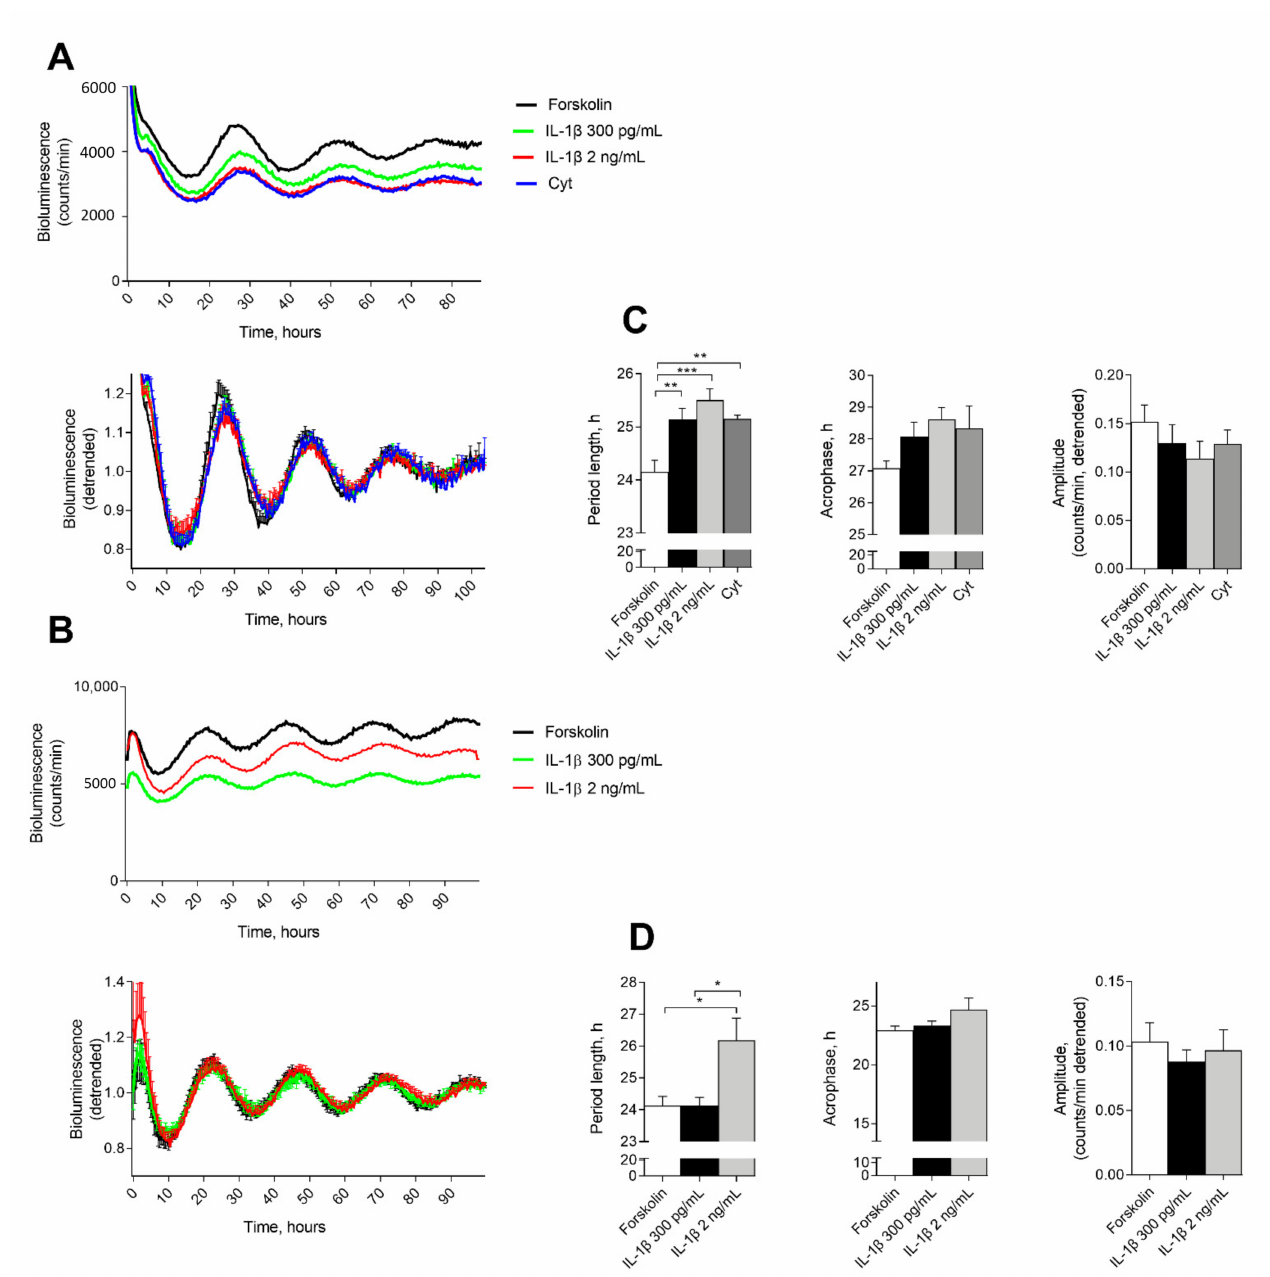
Figure 1. Proinflammatory cytokines alter the molecular clockwork in synchronized mouse and human Per2-luciferase (Per2-luc) reporter islets. ( A , B ) Average raw (top panels) and detrended (bottom panels) Per2-luc oscillatory profiles recorded from forskolin-synchronized mouse ( A , n = 5 of independent islet isolations with 2–3 animals per isolation) and human ( B , n = 4 of human donors) islets in the presence of interleukin-1 β (IL-1 β ) in the indicated concentrations or a combination of 300 pg/mL IL-1 β and 0.2 ng/mL interferon- γ (IFN- γ ) (Cyt). ( C , D ) Average period length, acrophase, and amplitude were calculated based on the detrended bioluminescence values for mouse ( C ) and human ( D ) islets. Values are means or means ± SEM. Statistics are one-way ANOVA with Tukey corrected multiple comparisons. Significance levels were annotated as follows: * = p -value < 0.05, ** = p -value < 0.01, *** = p -value <